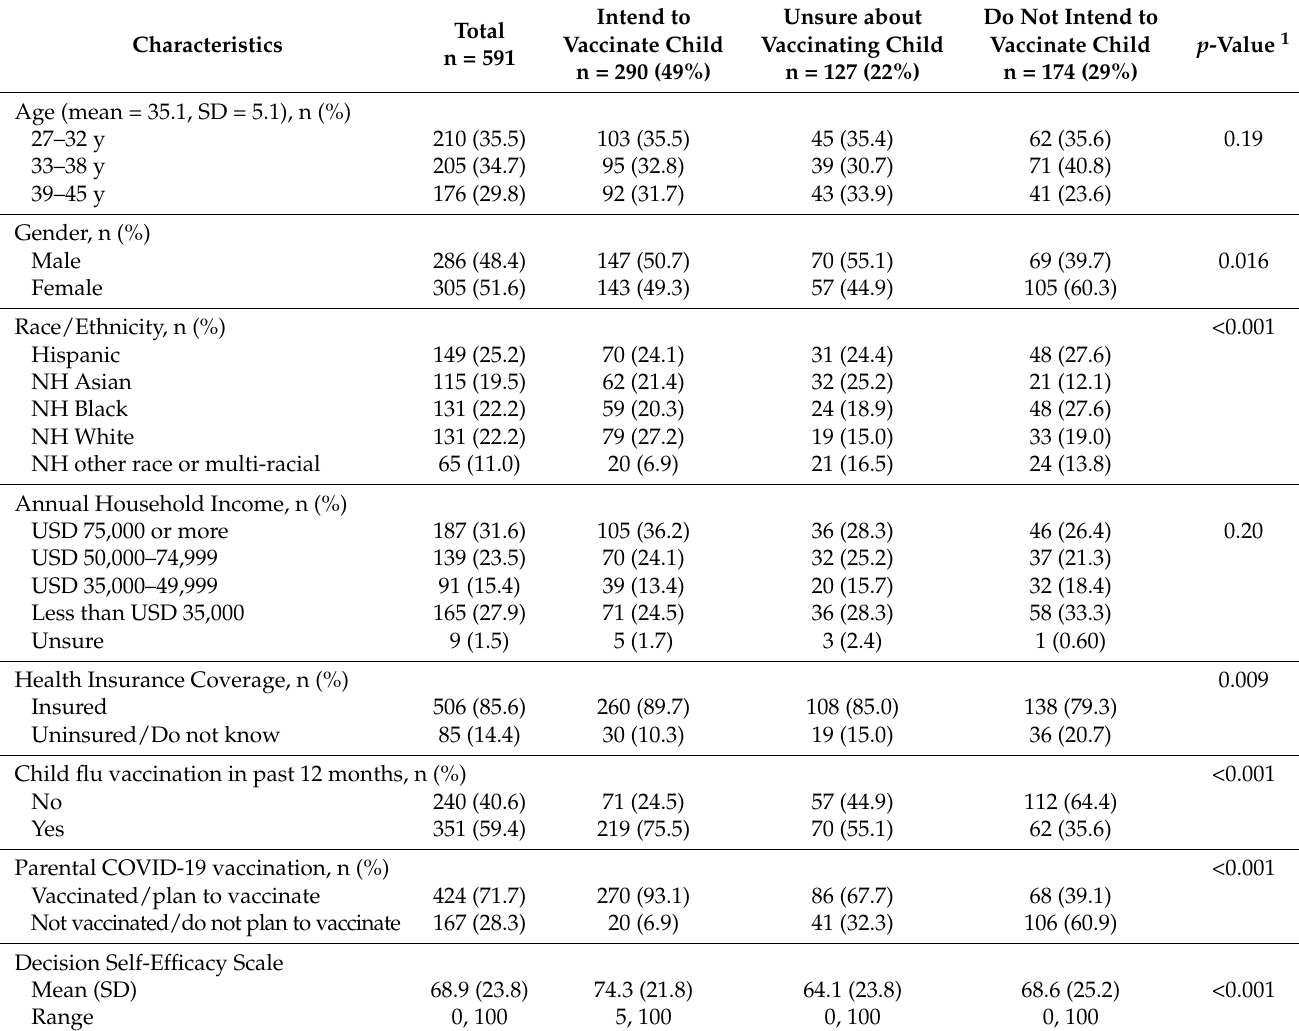
Table 1. Parent characteristics by intention to vaccinate child(ren) < 5 years for COVID-19, United States, 23 March to 4 April 2022, n = 591.